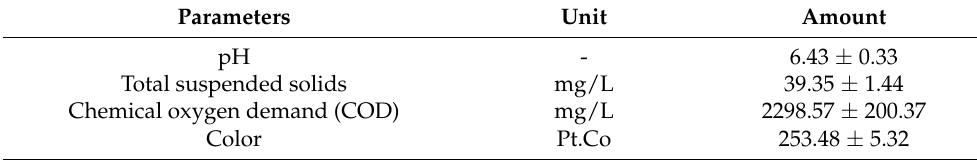
Table 10. The physiochemical characteristics of the influent wastewater used in this study. Parameters